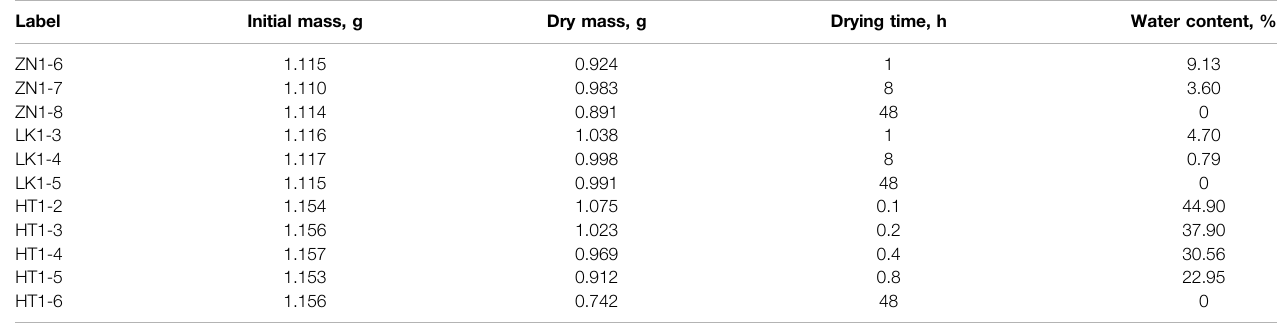
TABLE 3 | The sample information for water content test. Label